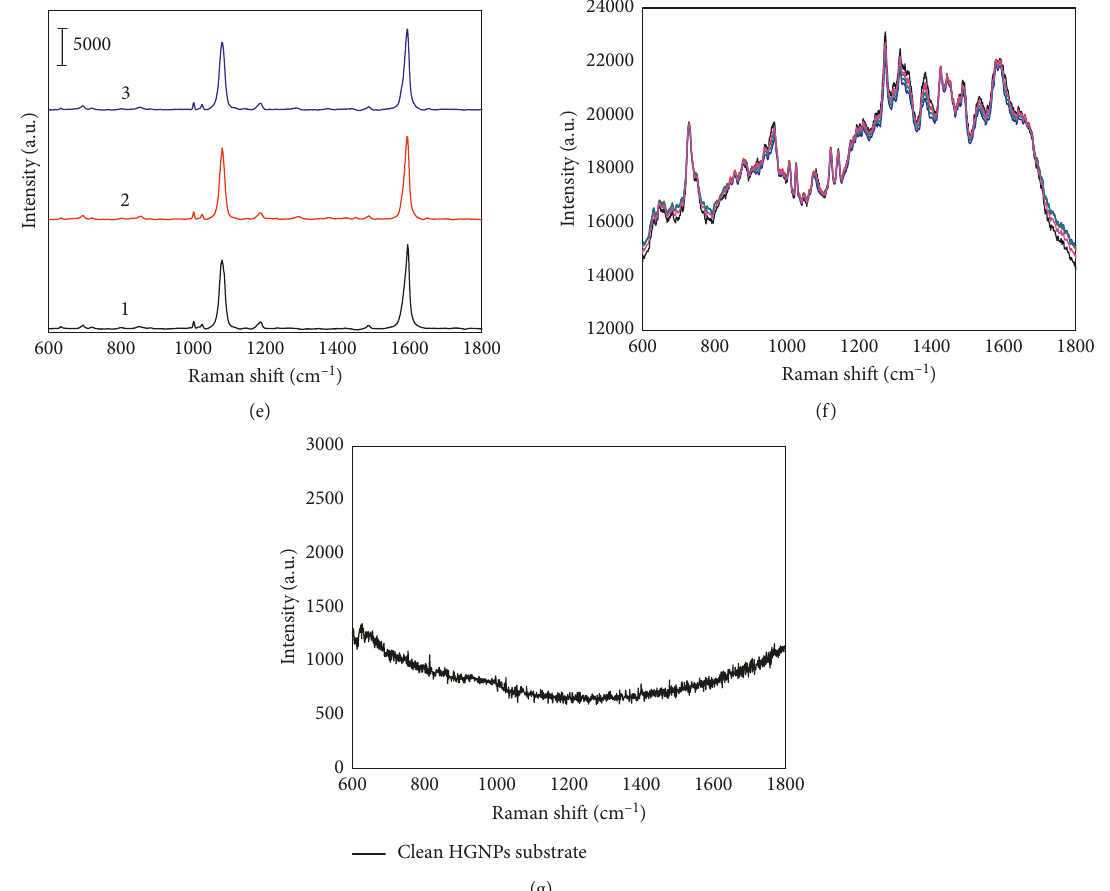
(g) 4 M). 4-MBA-labeled HGNP substrates were stored for 10 × 1 corresponding to the SERS spectra in (a). (c) SERS spectra − 10 , 1 9 , 1 8 , 1 7 , 1 6 , 1 5 , and 1 4 M) absorbed on the HGNP 10 10 10 10 10 10 10 − × × × × × × × 1 as a function of the concentration of 4-MBA. The inset is the calibration curve of − − − − − − − 8 to 1 4 M. (e) The reproducibility of HGNP substrates measured with 4-MBA (1 10 10 − × × − −